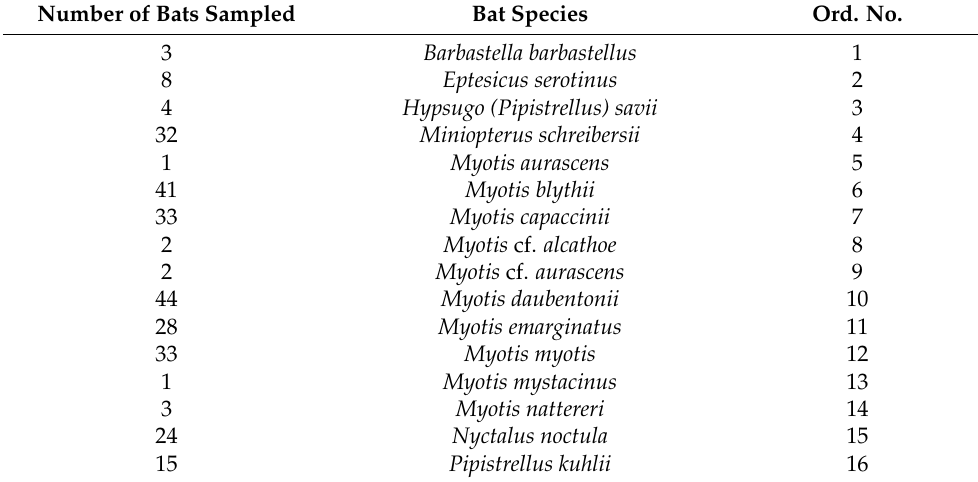
Table 3. Bat species sampled for active bat lyssavirus surveillance in Serbia (2007–2008) (from [25]). Number of Bats Sampled Bat Species Ord.